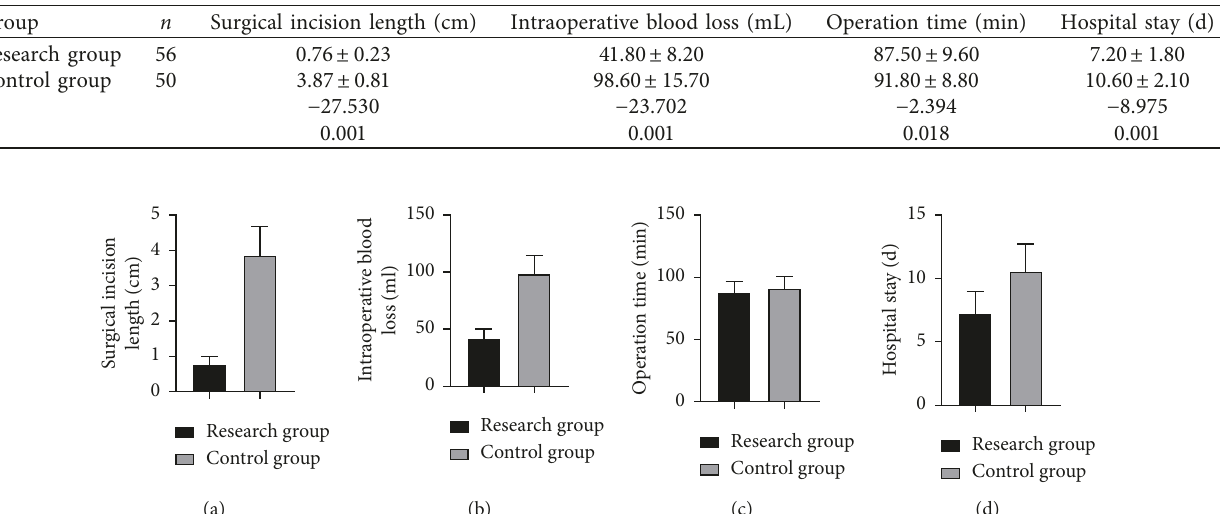
Table 2: Comparison of surgical trauma indexes between the two groups.